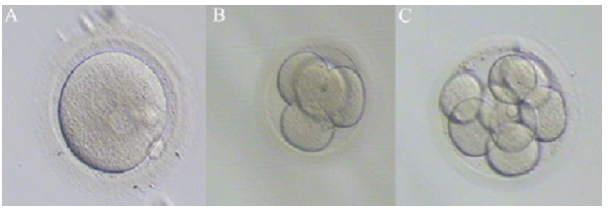
Fig 1. Images of embryos. 2PN on Day 1, 4-cell embryo on Day 2, 8-cell embryo on Day 3. PN = pronucleus.